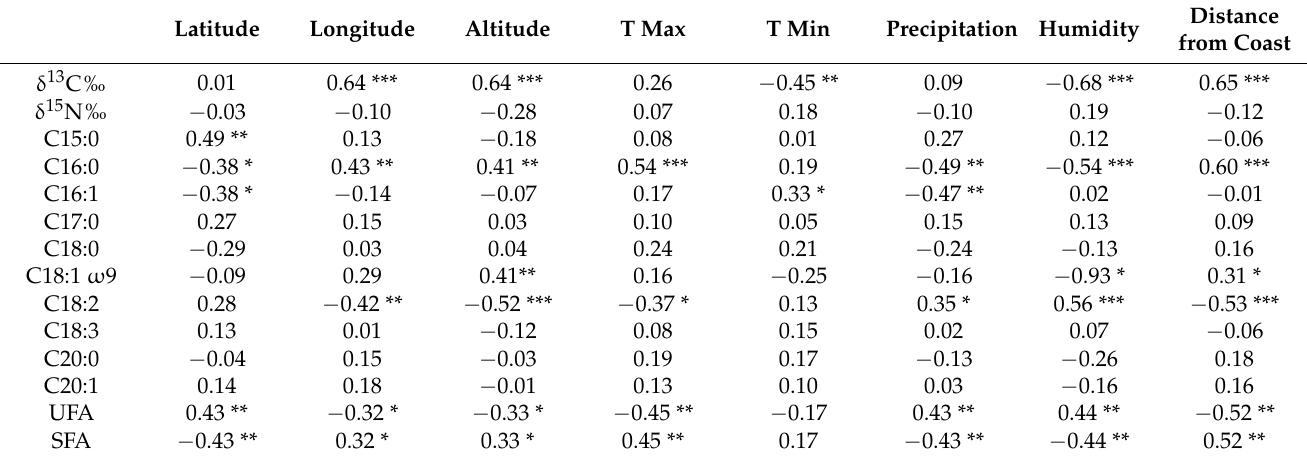
Table 2. Correlation of stable isotope ratios and fatty acid contents of Argan oil from six provenances with geographical pa-